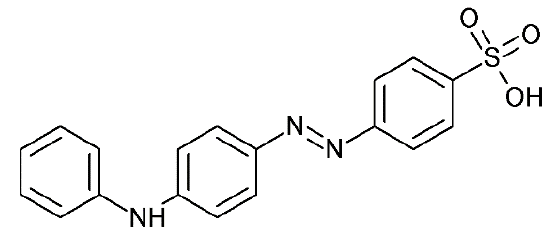
Figure 1. Structure of tropaeoline OO.